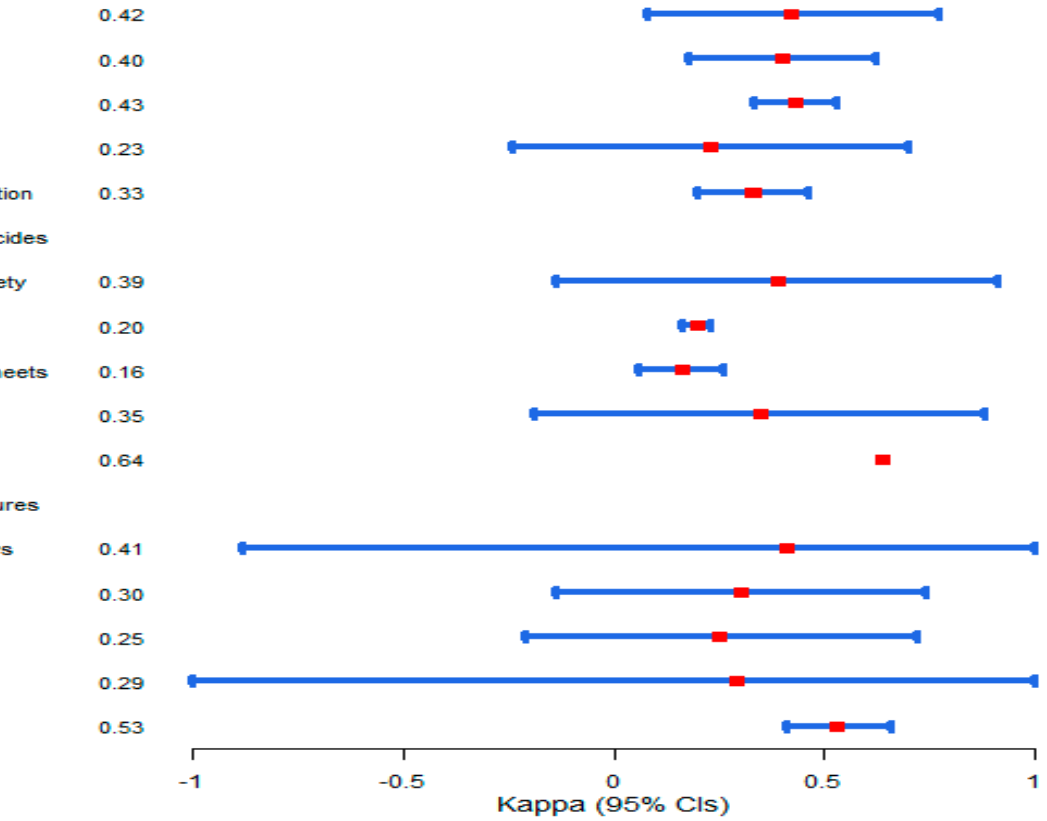
Figure 1. Kappa for agreement (95% confidence intervals) between 15 safety practices and 15 safety priorities in farm and ranch operators in 7 Midwest states, 2021. (Kappa statistic in red; blue bars represent 95% confidence interval)